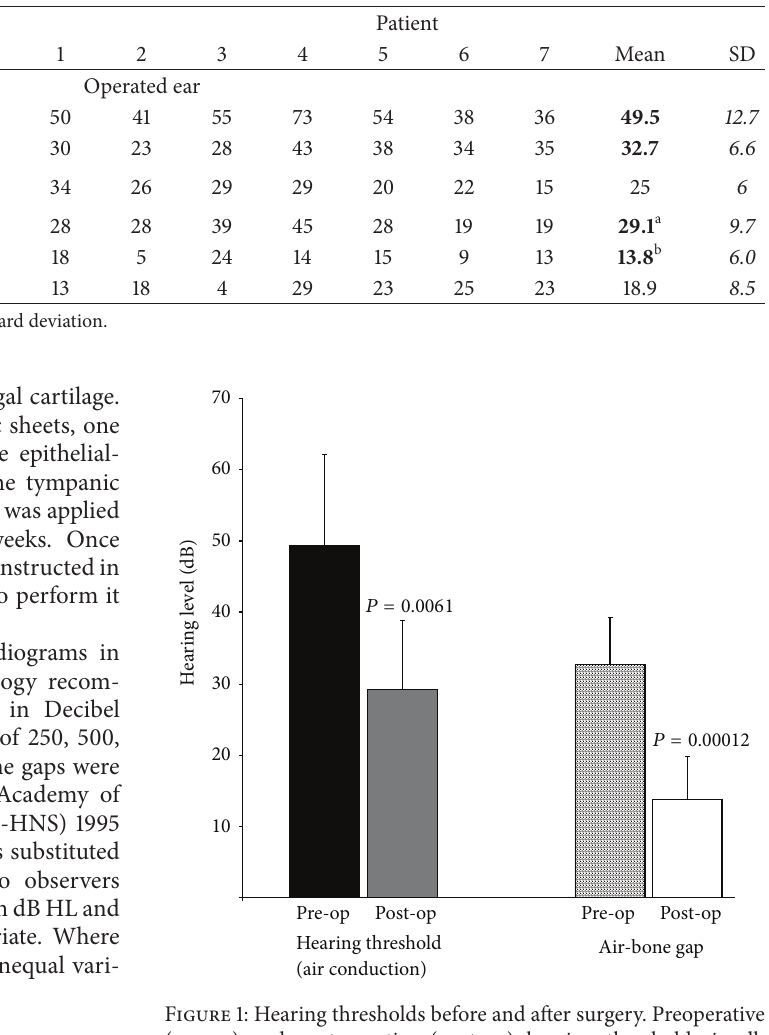
Table 1: Comparison between pre- and postoperative audiograms and assessment of air-bone gap.